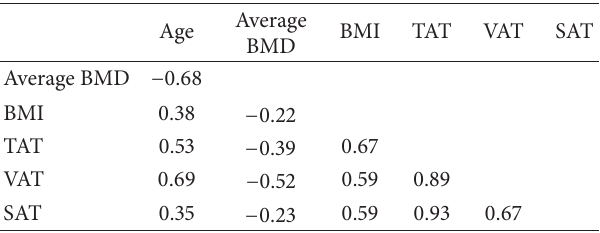
Table 2: Correlations ( r ) between adiposity, age, BMI, and BMD in group aged < 55 years.